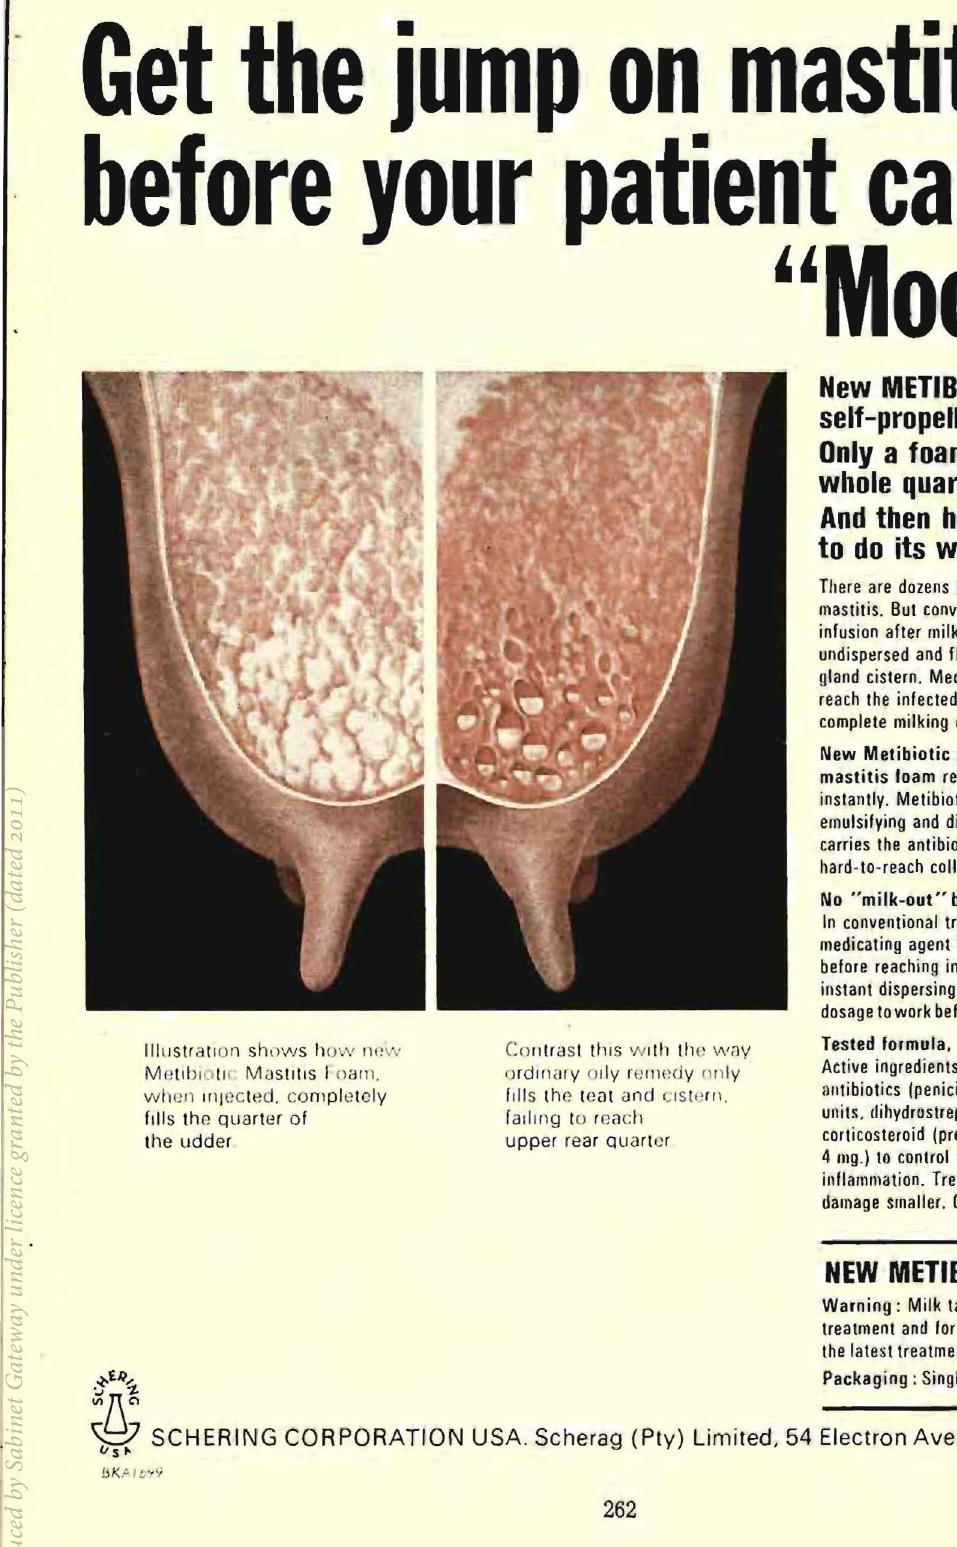
inflammation. Treatment is faster, tissue damage smaller. Cost is low. NEW METIBIOTIC Warning: Milk taken from animals during treatment and for 72 hours (6 milkings) after the latest treatment must not be used for food. Packaging: Single dose containers, boxof